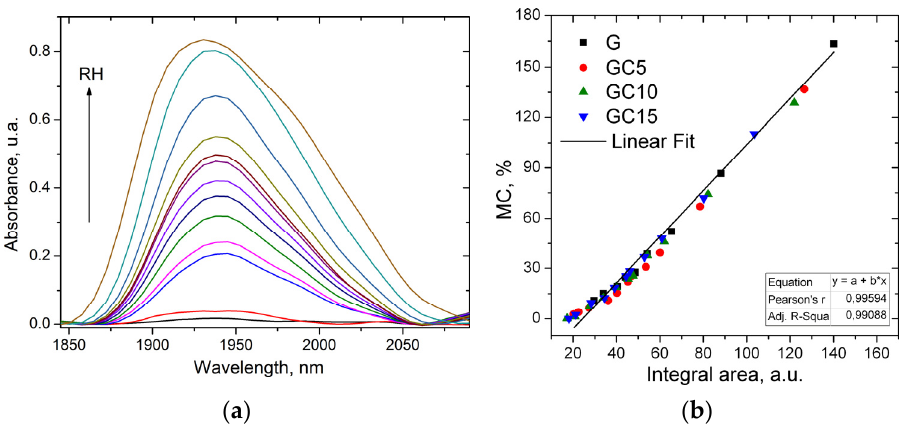
Figure 6. The band at 1940 nm for the GC15 sample in the sorption process ( a ), and the integral area plotted as a function of the MC for gelatin and composite films ( b ).